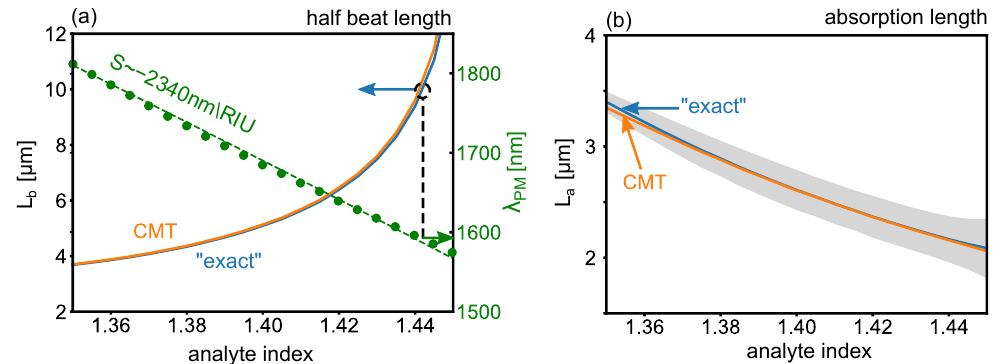
Figure 7. ( a ) Green (right axis): phase matching wavelength λ PM where β 1 = β R beat length L b according to the supermodes obtained with CMT (orange) and “exact” calculations (blue). ( b ) Associated absorption length L a . Solid lines indicate the average L a = ( L 1 a + L 2 a ) /2; shaded regions encompass the L 1 a and L 2 a boundaries.